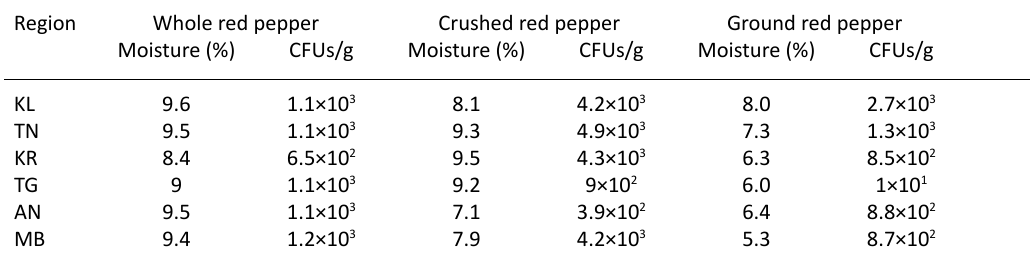
table 1. Total fungal load and moisture content of red peppers with more than two months storage Region Whole red pepper Crushed red pepper Ground red pepper